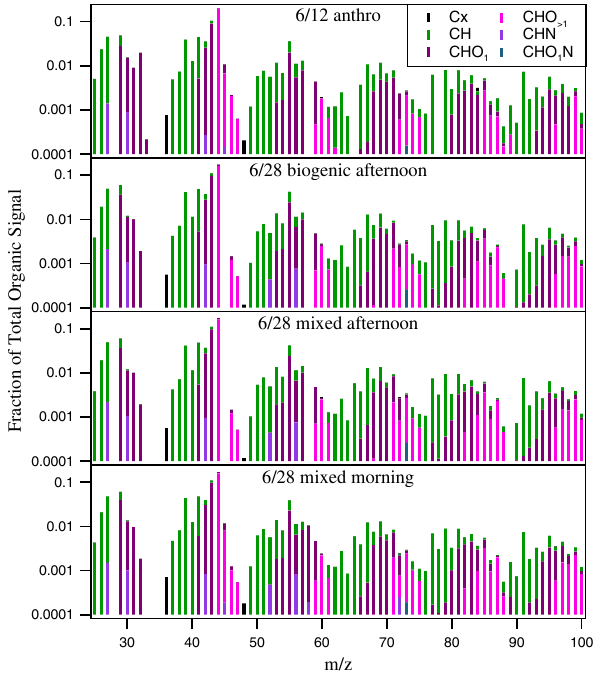
Fig. 6. Representative HR-AMS spectra of the OA sampled during CARES for the airmasses discussed in detail in the text. Each spec- trum is divided by the total OA loading over that period such that spectral peaks represent a fraction of the total organic signal. Inten- sity at each nominal amu is broken down into the ion family shown in the legend. Only signal from organic ions is shown.